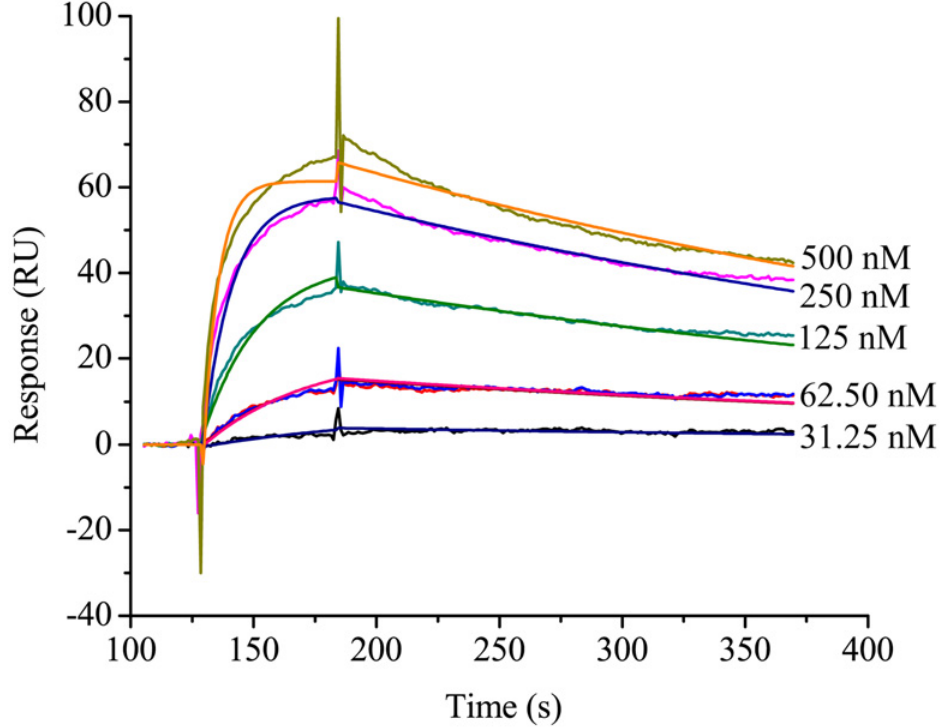
Fig 6. The affinities of binding of Cry1Ac to HaALP1f. Experimental curves (jagged line) are shown overlaid with fitted curves (smooth line) obtained with the 1:1 Langmuir binding model. The overlaid BIAcore response curves are shown for HaALP1f injections at 31.25, 62.5, 125, 250, and 500 nM.